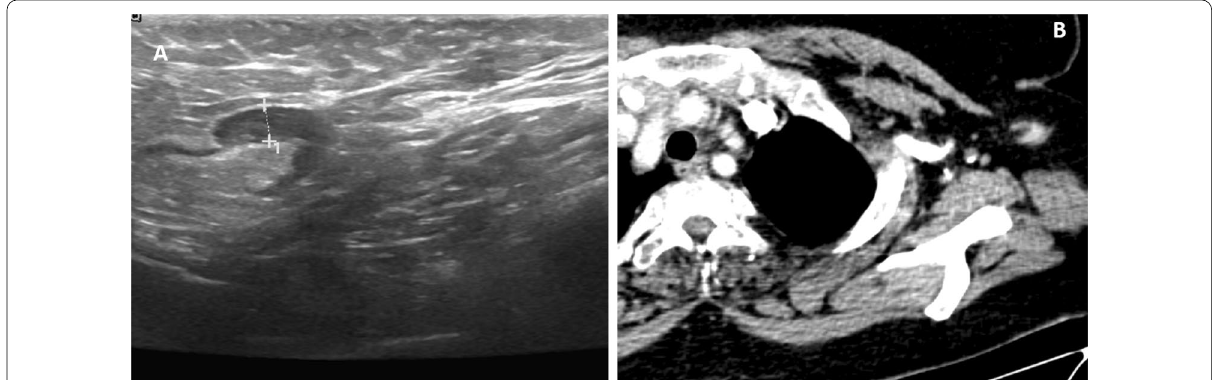
Fig. 1 A 70‑year‑old female with left pathologically proven metastatic axillary lymph node. A Axillary ultrasound image shows indeterminate LN with focal cortical thickening measuring 5 mm (true positive). B CT image shows an indeterminate axillary LN with focal cortical thickening measuring 11 mm (true positive). LN; Lymph node, CT; computed